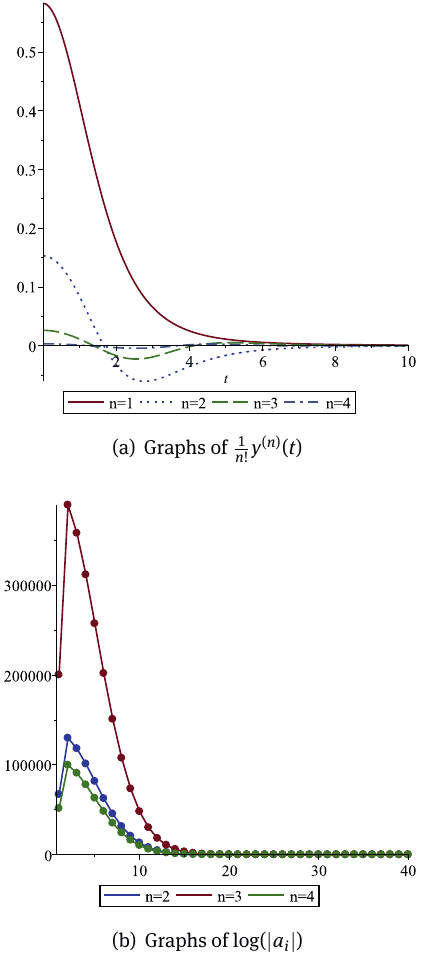
Fig. 7: (a) Graphs of 1 y ( n ) ( t ) for n = 1, 2, 3, 4 (b) Graphs of log( | a i | ) n ! for n = 2, 3, 4 to show the